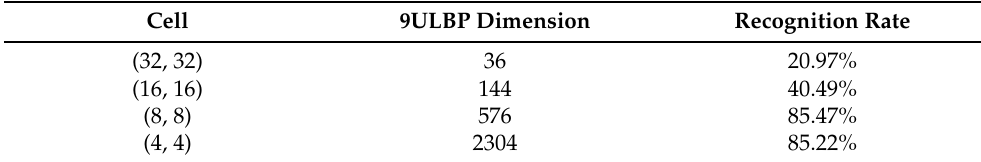
Table 2. Performance of 9ULBP with different sizes.